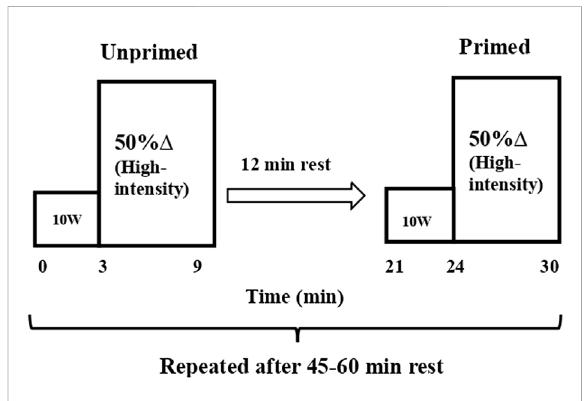
FIGURE 1 Schematic representation of the protocol. Unprimed and primedcyclingsteptransitionsperformedathigh-intensitycycling exercise ( Δ 50%; the sum of the power output at VT and 50% of the difference between the power output at VT and V step transitions, each lasting 6 min, were preceded by 3 min of cycling at 10 W (i.e. ‘ baseline ’ cycling). Unprimed and primed transitions were separated by 12 min of passive rest. The 2 step transitions (unprimed and primed) were repeated following 45 – 60 min of passive rest within the same laboratory